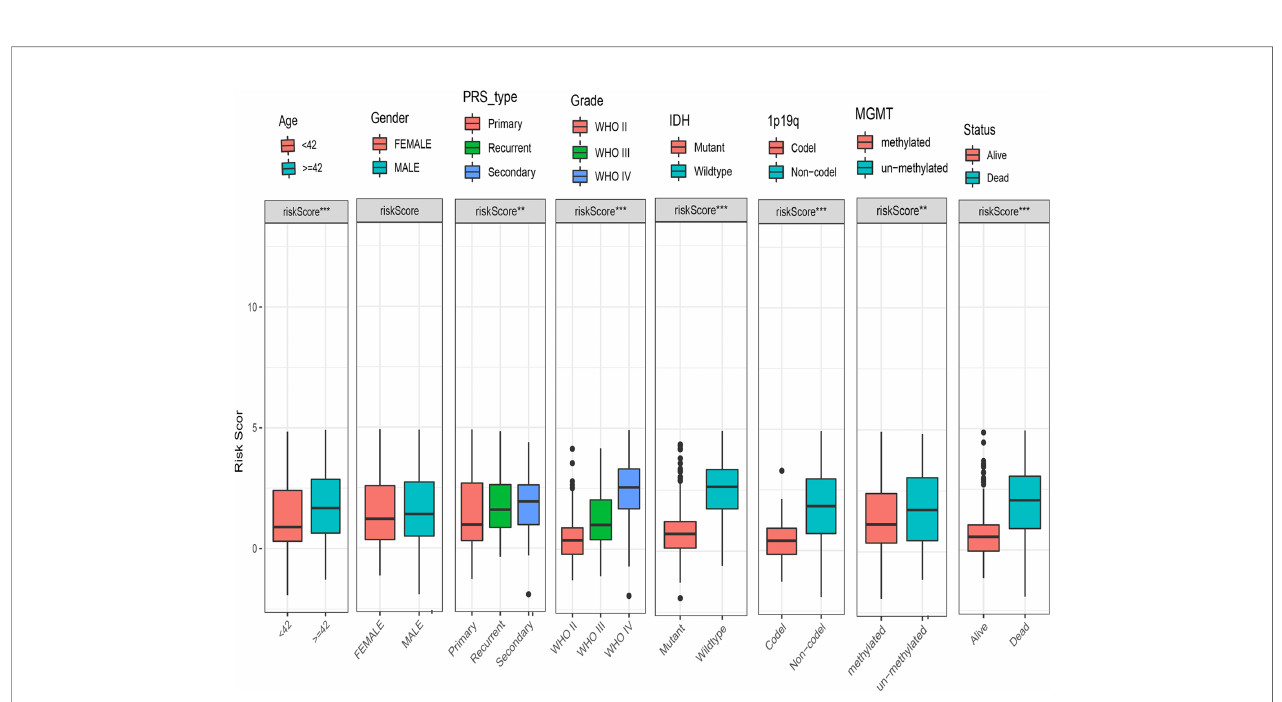
FIGURE 6 | Box charts showing the characteristics of patients in different risk groups, including age, sex, PRS type, grade, IDH, 1p19q, MGMT, and survival status. IDH, isocitrate dehydrogenase; MGMT, O-6-methylguanine-DNA methyltransferase; PRS,